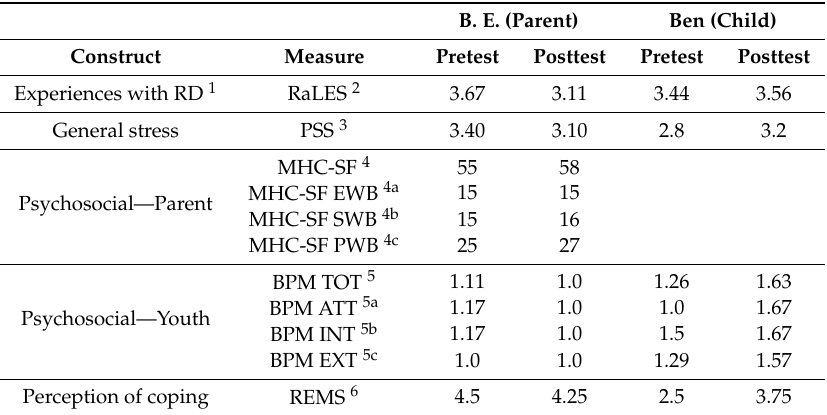
Table 3. Parent and child pre- and post-intervention scores.